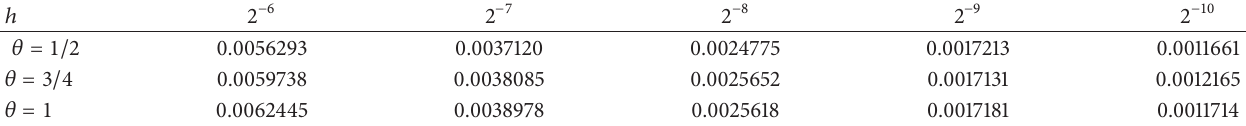
Table 2: The means of absolute errors 𝜖 with 𝑡 𝑁 = 2 of SST (3) for solving SDDE